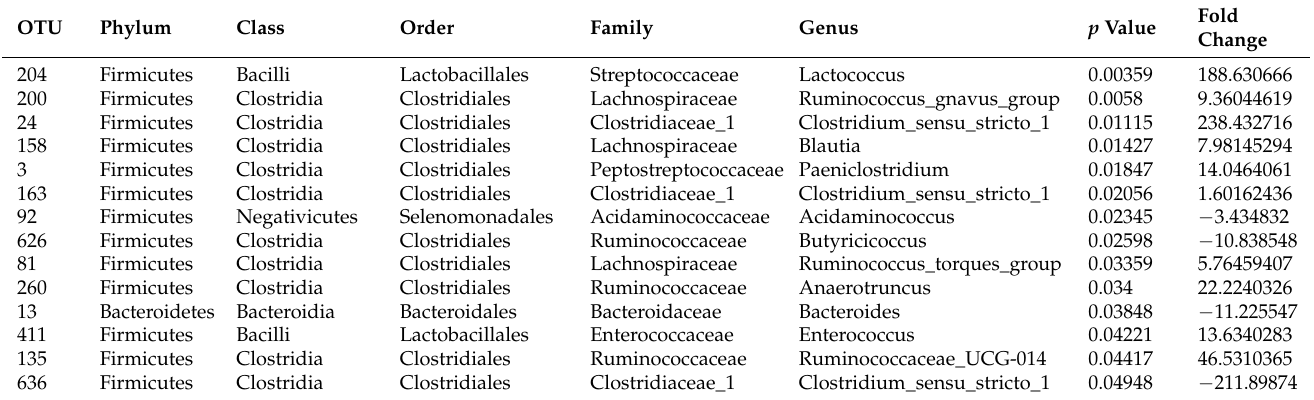
corihominis , and Rilenellacea.